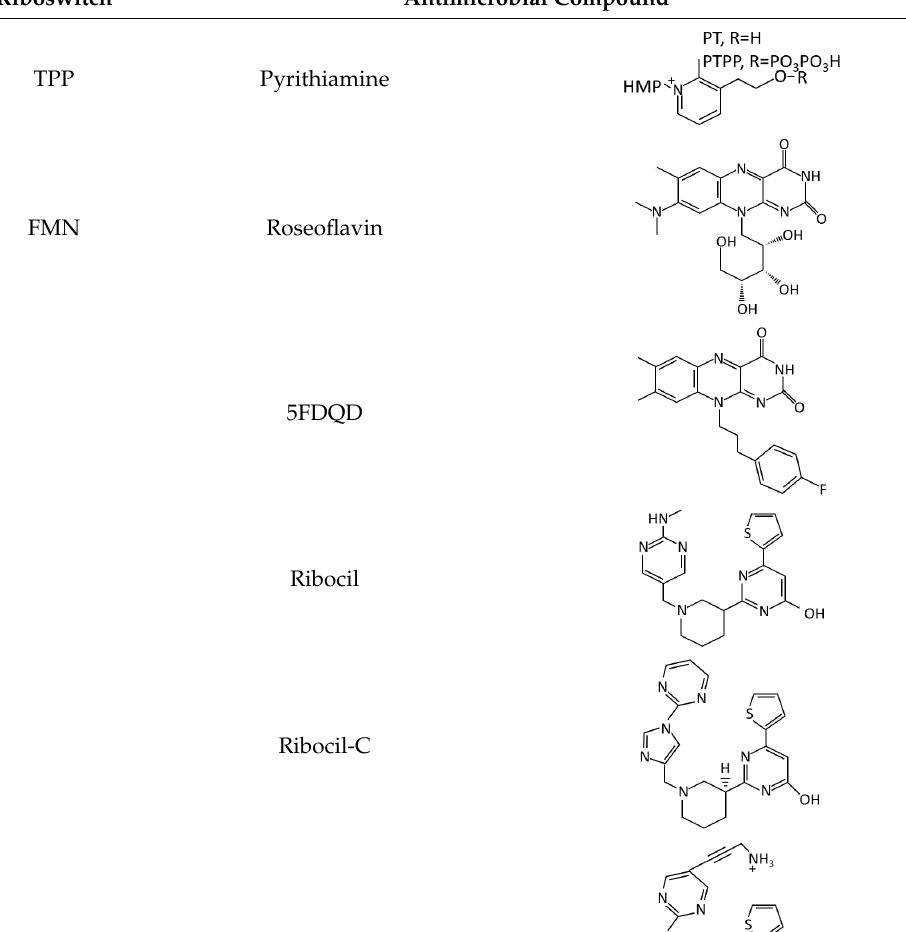
Table 1. List of the compounds that target a specific class of riboswitches and exhibit antimicrobial activity for each of the indicated organisms.